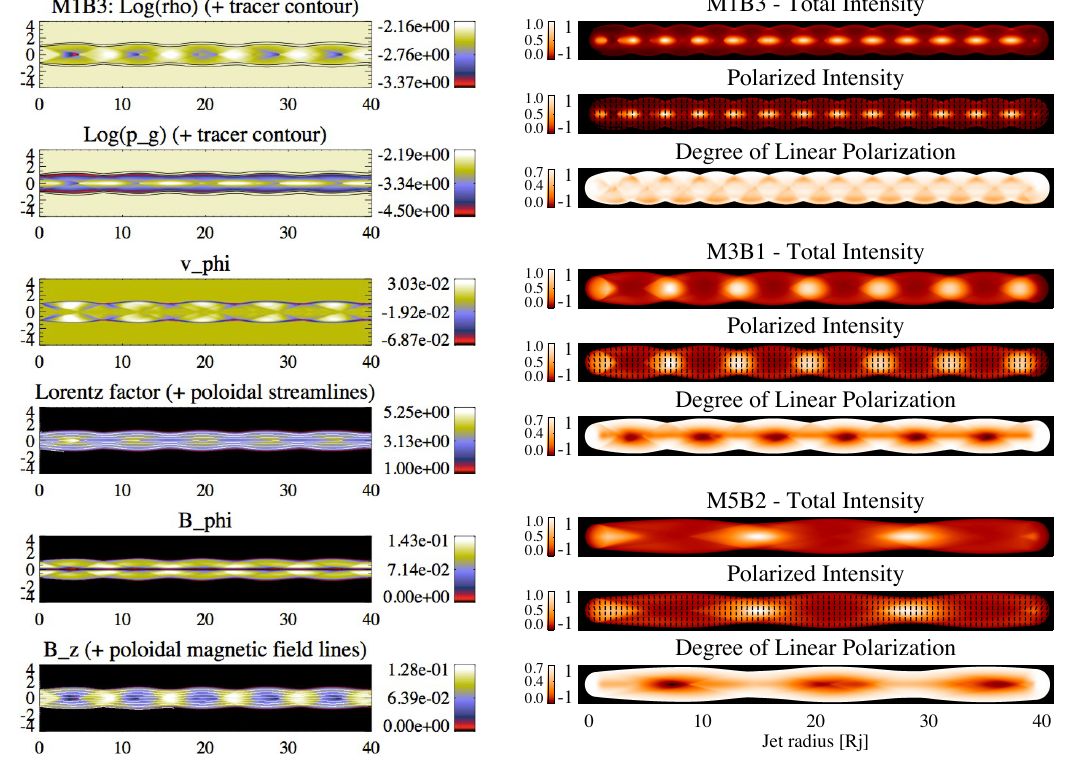
Figure 4. ( Left ) Steady structure of a magnetically dominated relativistic jet model. From top to bottom: Distributions of rest-mass density, gas pressure, toroidal flow velocity, flow Lorentz factor, and toroidal and axial magnetic field components. Poloidal flow and magnetic field lines are overimposed onto the Lorentz factor and axial magnetic field panels, respectively. ( Right ) Synthetic total and polarized synchrotron intensities and degree of linear polarization from RMHD jet models at 20 ◦ to the line of sight. Top panel (M1B3 model): magnetically dominated jet corresponding to the RMHD models on the left; middle panel (M3B1): hot jet; bottom panel (M5B2): kinetically dominated jet. (Figure adapted from Figures 2 and 14 of [128] ©AAS. Reproduced with